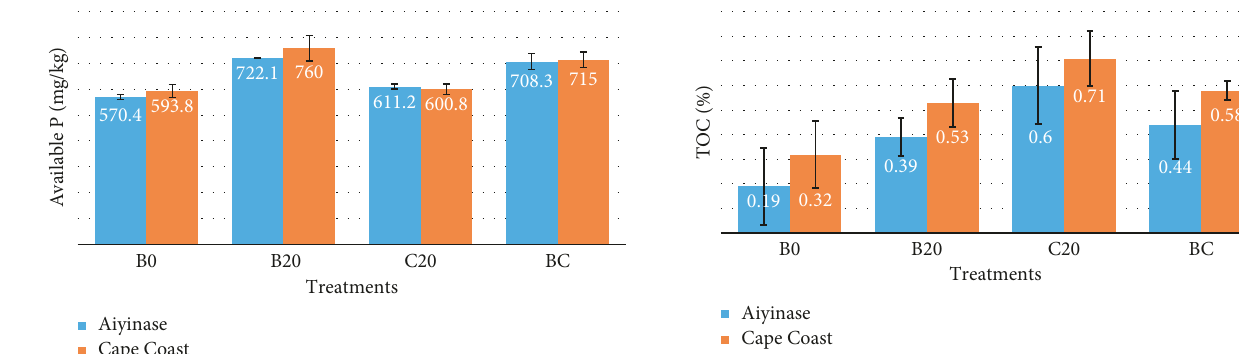
Figure 2: Changes in soil available phosphorus of Aiyinase and Cape Coast soils following application of corncob biochar and/or compost 14 days after incubation. B0 � control with no amendments; B20 � biochar 2%, w/w; C20 � compost 2%, w/w; BC � combined biochar and com- post rate 1% compost+1% biochar. Error bars represent standard deviation of the means.